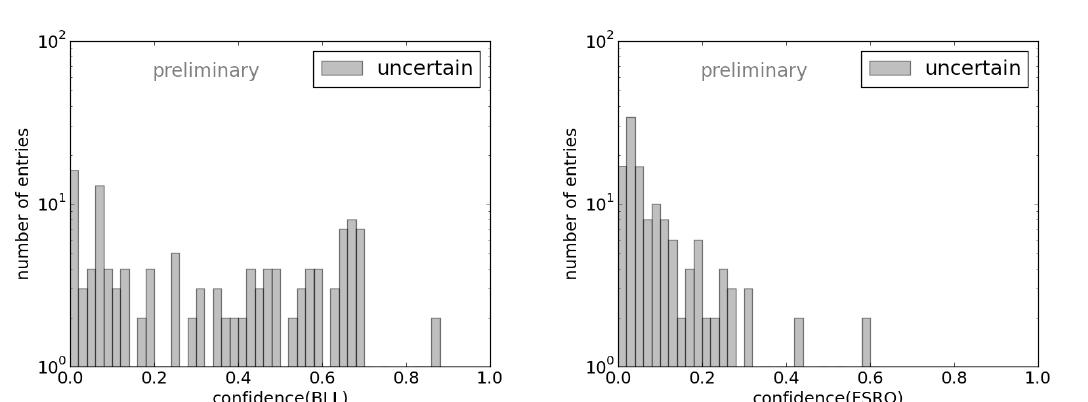
Figure 6. Confidence distribution for the BLL ( left ) and the FSRQ class ( right ). The classification model is applied to the data set of AGNs of uncertain type extracted from the 3FGL and the 1SXPS catalogs.